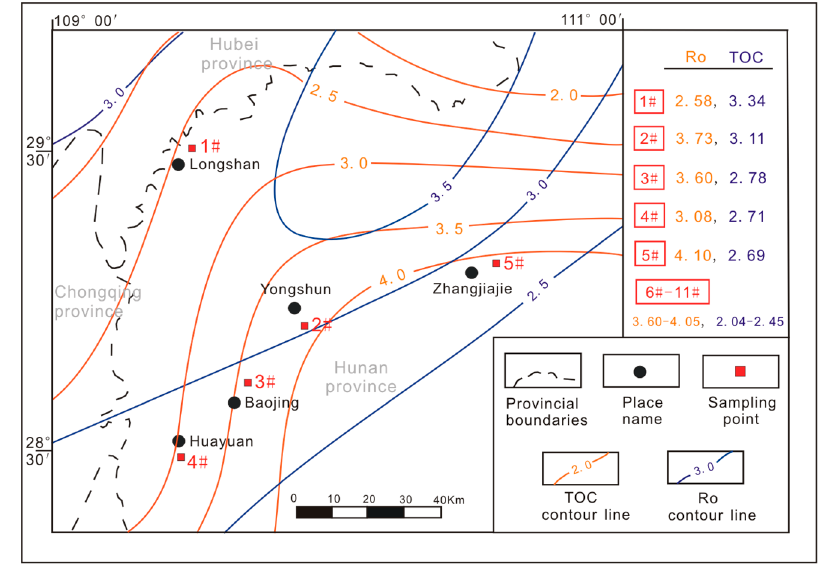
Figure 5. TOC (total organic carbon) and Ro (thermal maturity) distribution contour maps of Niutitang Formation shales in northwestern Hunan.